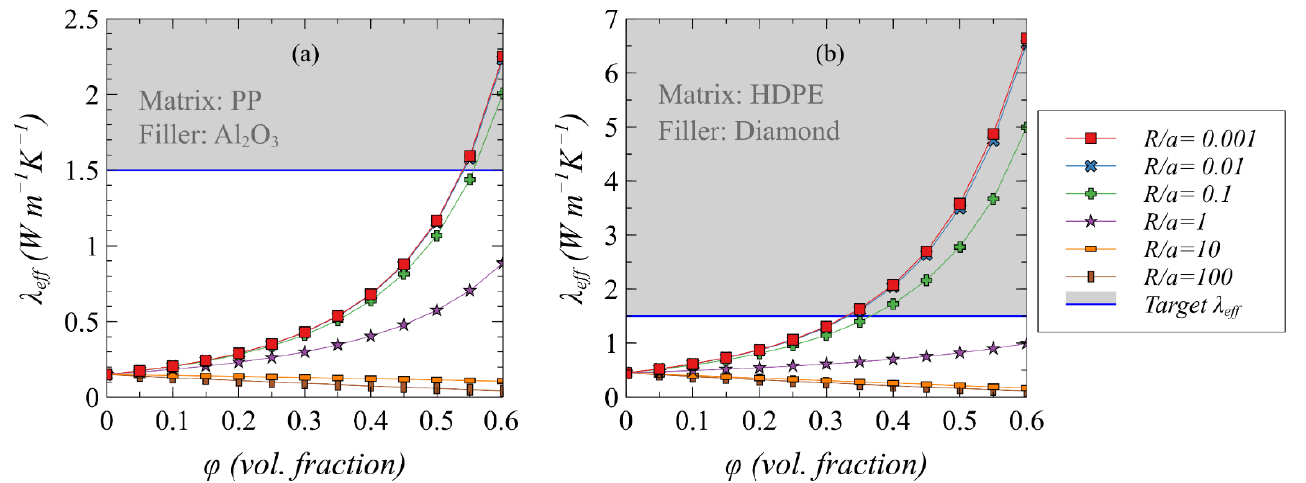
Figure 2. The predicted effective thermal conductivity considering the lowest and highest intrinsic thermal conductivity combinations of matrices and fillers with different R int / a k ratios. ( a ) PP with spherical Al 2 O 3 fillers. ( b ) HDPE with spherical diamond particulates.